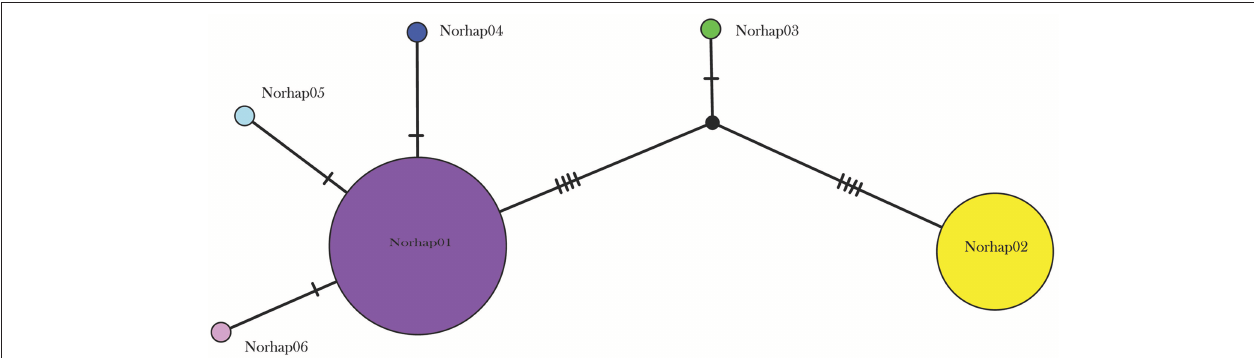
FIGURE 1 | Median joining haplotype network for 130 R. norvegicus individuals from across the New Zealand archipelago.